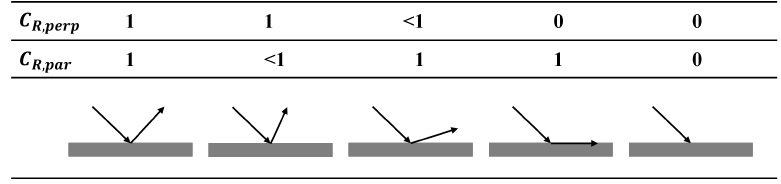
Figure 2. The schematic of the wall treatment method